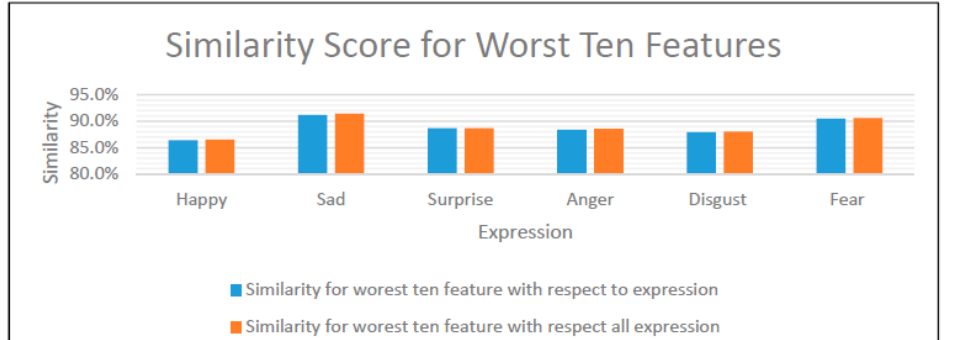
Figure 26. SS for worst ten features with respect to each expression vs. all expressions.